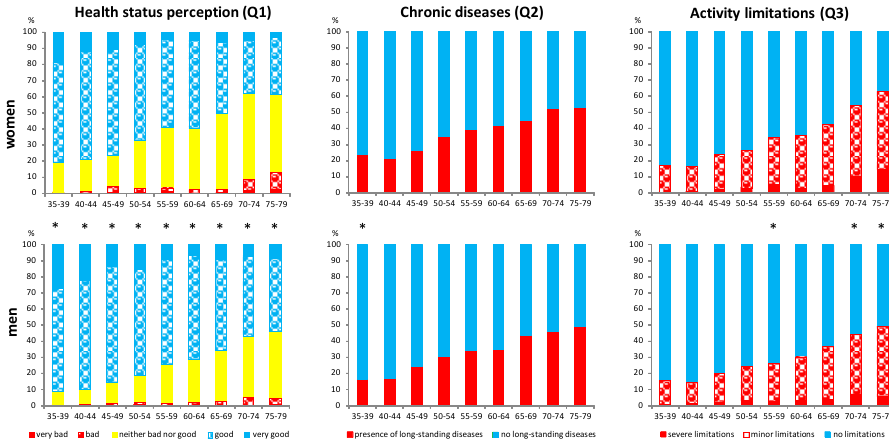
Figure A1. Frequency distributions of the answers to the three MEHM items, expressed as a percentage of number of participants within each age group, for women and men. (Data source: the CUORE Project Health Examination Survey 2008–2012, Italian men and women, 35–79 years old). * Indicates significant differences between women and men age-matched groups (2, p < 0.05)